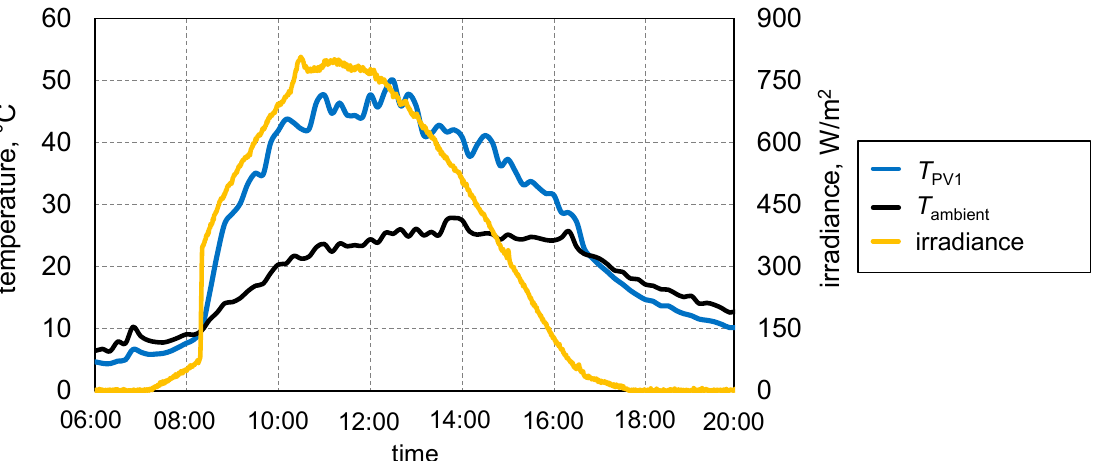
Figure 6. Measured solar irradiance, ambient temperature, and temperature of the PV panel during measurements.